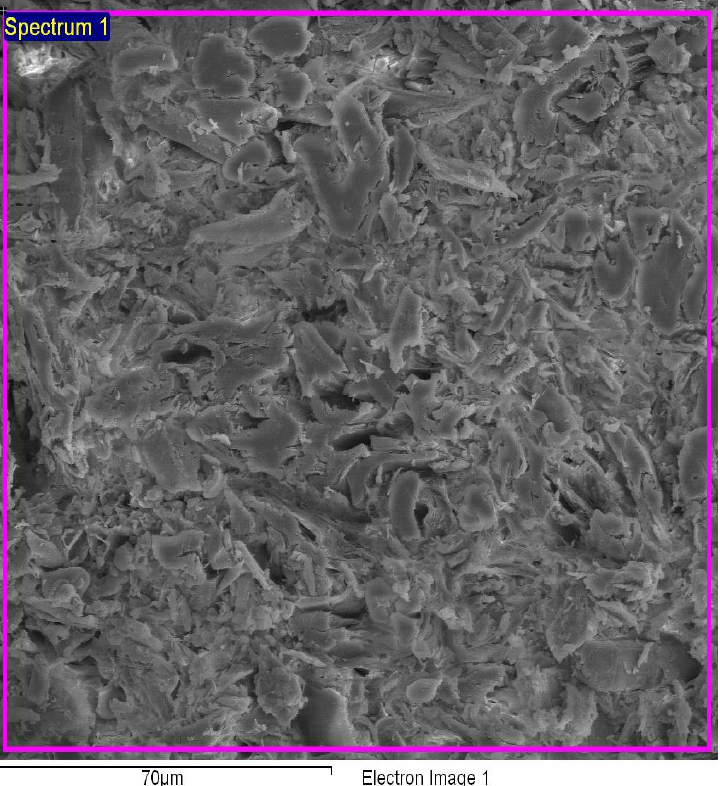
Figure 9. Micrograph of Rhizophora spp. particleboard bonded with 12% binders.